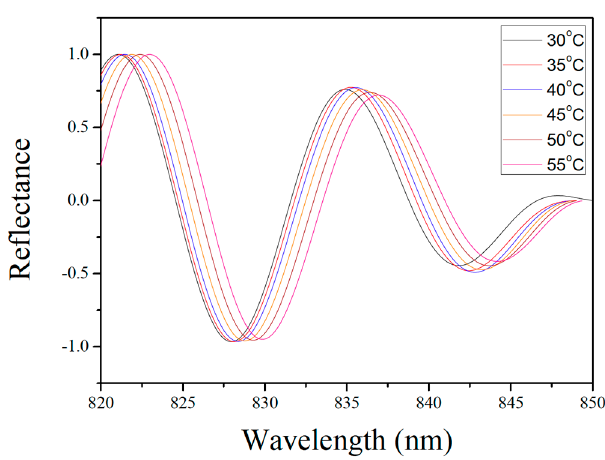
Figure 6. Simulated reflection spectra for different temperatures.